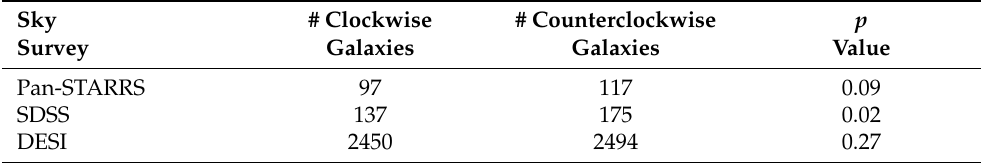
Table 2. The distribution of clockwise and counterclockwise galaxies in the field centered around the opposite hemisphere of the HST COSMOS field. The P values are computed by the accumulated binomial distribution assuming 0.5 mere chance probability of a galaxy spinning in a certain direction. Sky # Clockwise # Counterclockwise p Survey Galaxies Galaxies Value Pan-STARRS 97 117 0.09 SDSS 137 175 0.02 DESI 2450 2494